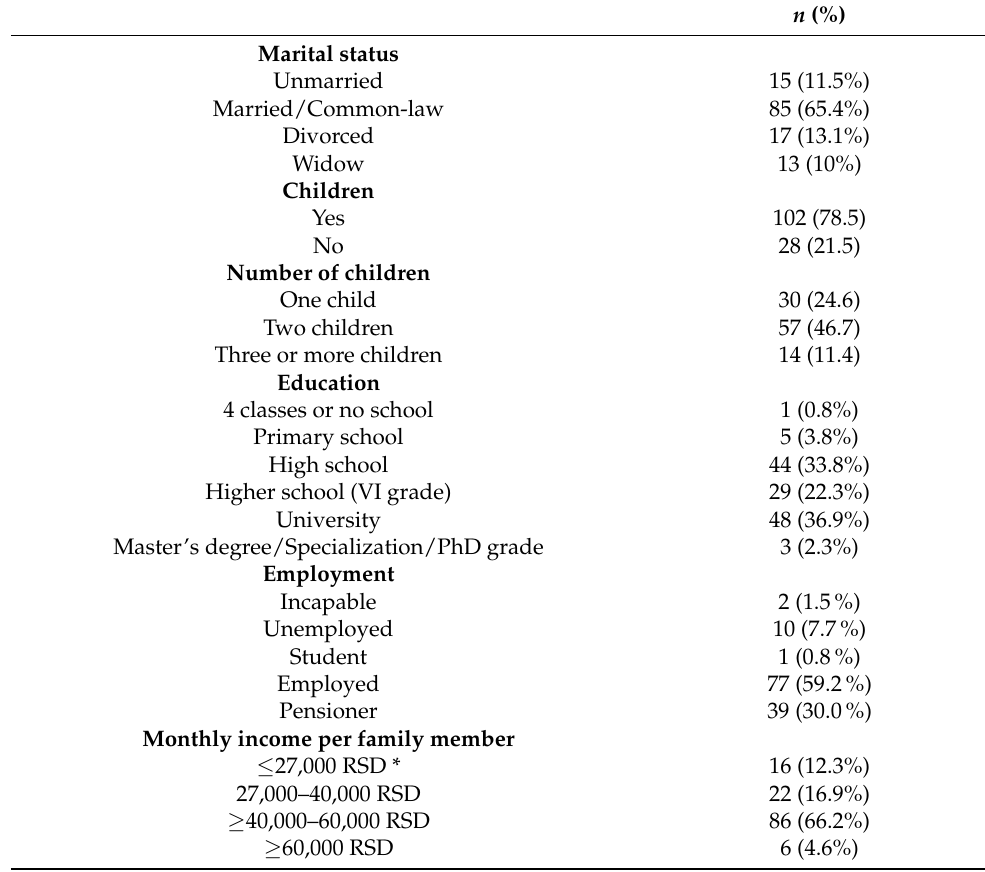
Table 3. Characteristic of 130 participants in the validation